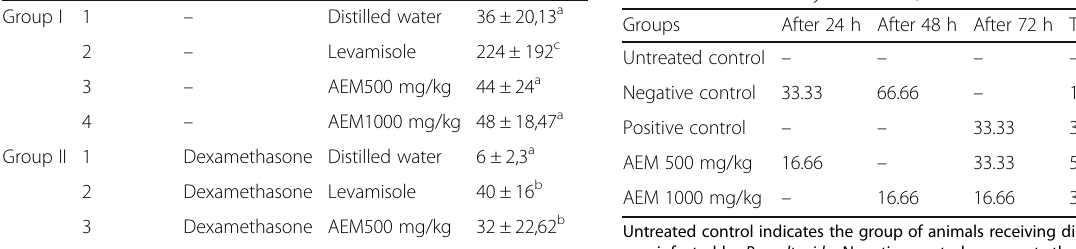
Table 3 Effect of the treatment by T. clypeatus on haemagglutination titer level in mice Groups Subgroups Treatment Table 4 Mice lethality rate at 24, 48 and 72